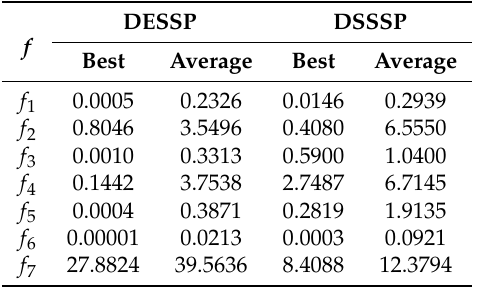
Table 9. Error gap results obtained by the DESSP and DSSSP methods.